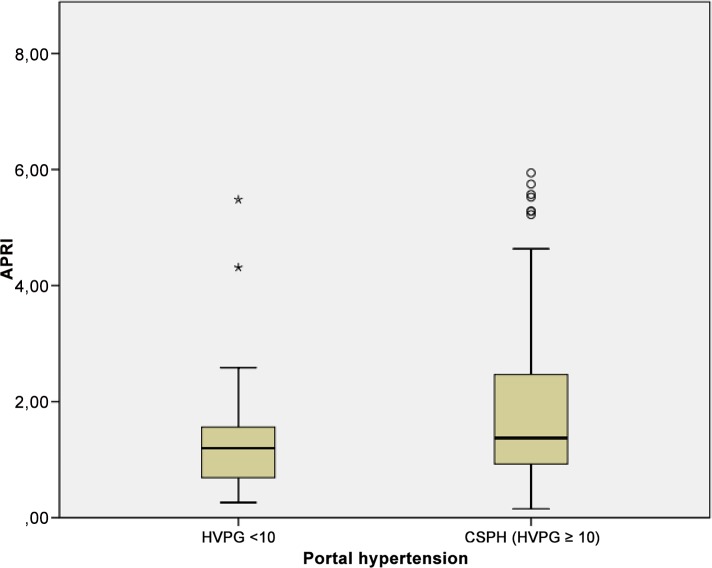
Correlation of aspartate aminotransferase to platelet ratio index (APRI) and CSPH.Mean values of APRI shown in boxplots for a cohort of patients with and without CSPH each.